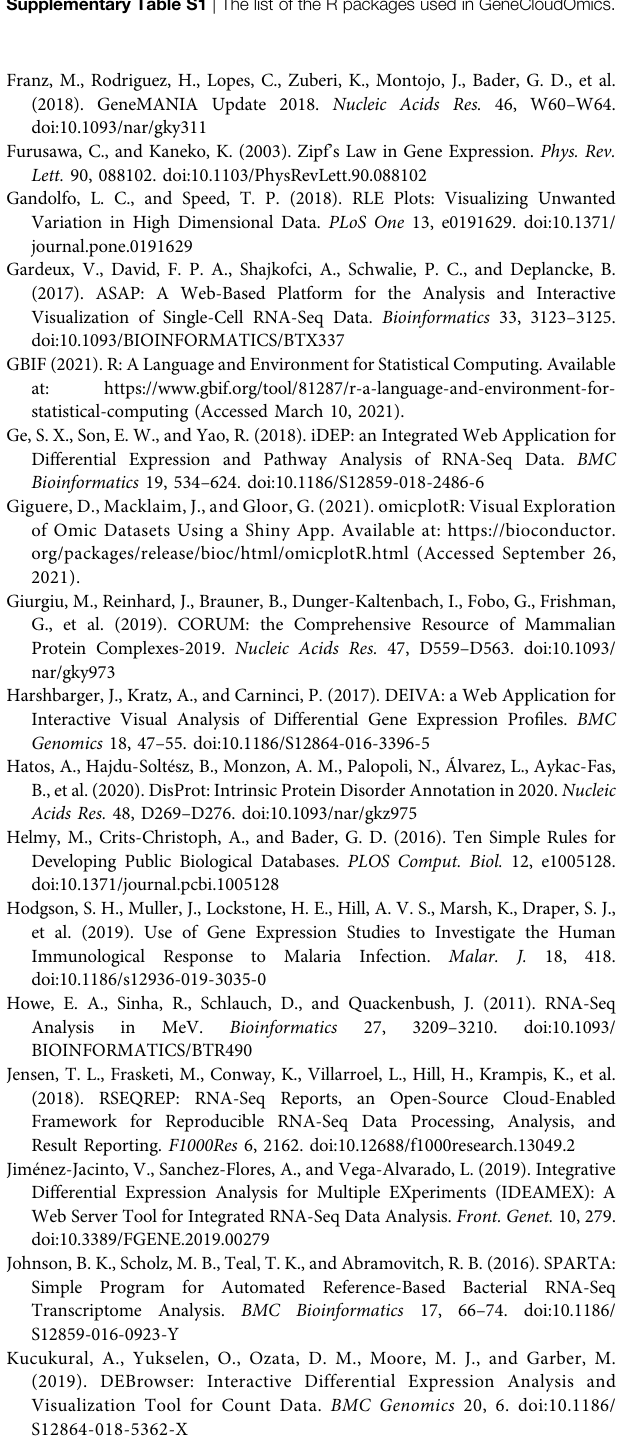
Supplementary Figure S2 | Protein bioinformatics analysis for the upregulated proteins set. (A) gene ontology (GO), (B) protein-protein interaction, and (C) protein phylogenetic tree, (D) protein pathological analysis, and (E) Protein physicochemical properties (acidity, charge and hydrophobicity). Supplementary Table S1 | The list of the R packages used in